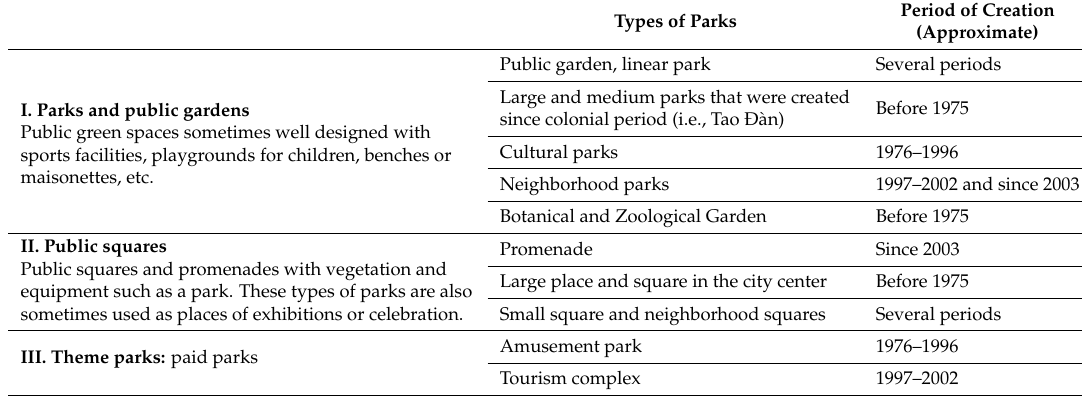
Table 1. Different types of parks in Ho Chi Minh City (HCMC) by their name and their period of